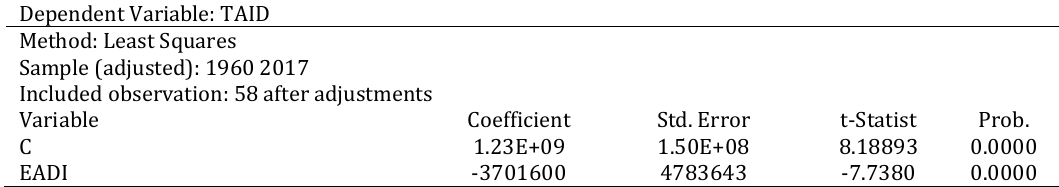
Table 11. Estimation of Total Bilateral aid received